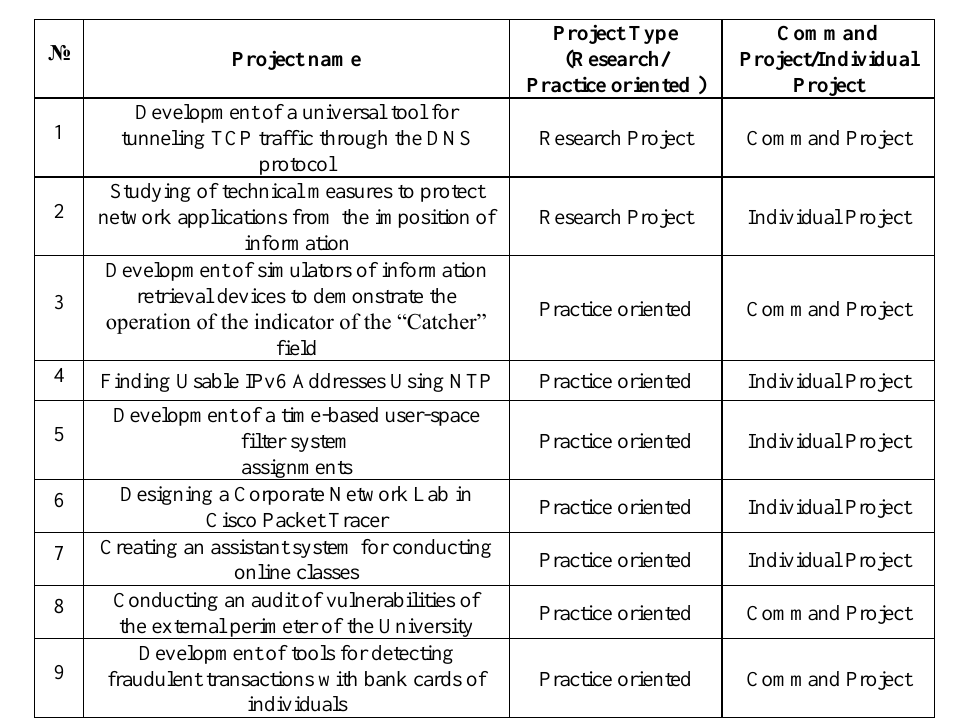
Table 3. Student Project